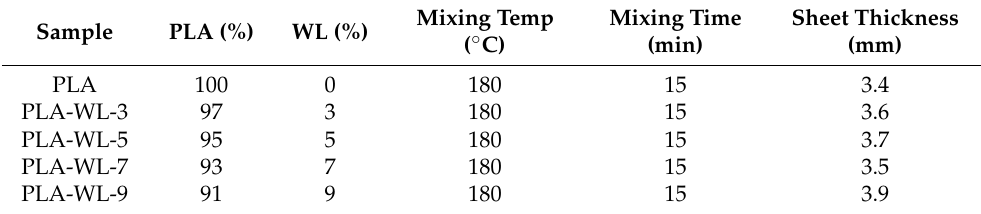
Table 1. Manufacturing parameters of PLA-WL biocomposites produced in this